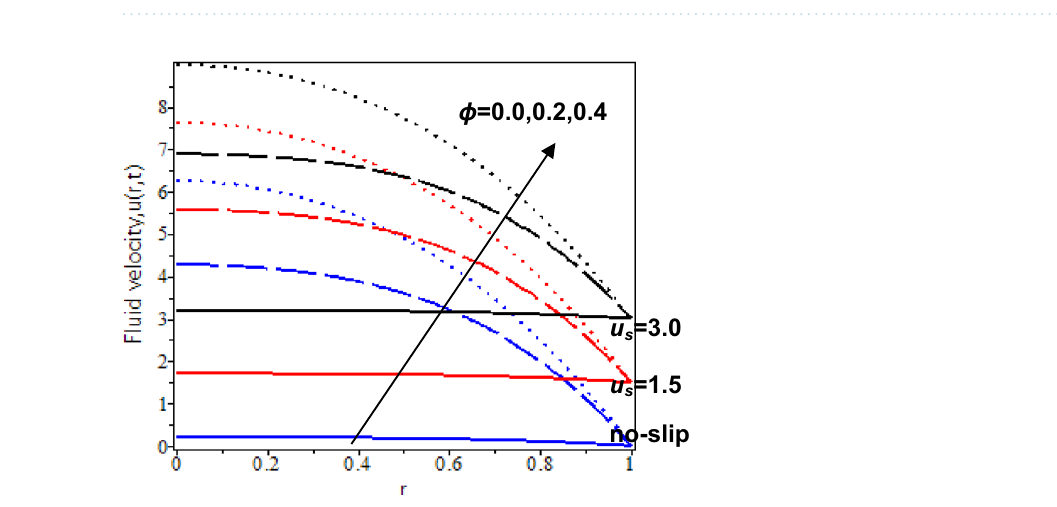
Figure 9. Nanofluid velocity with various nanoparticles volume fraction and slip velocity at t = 0.5.